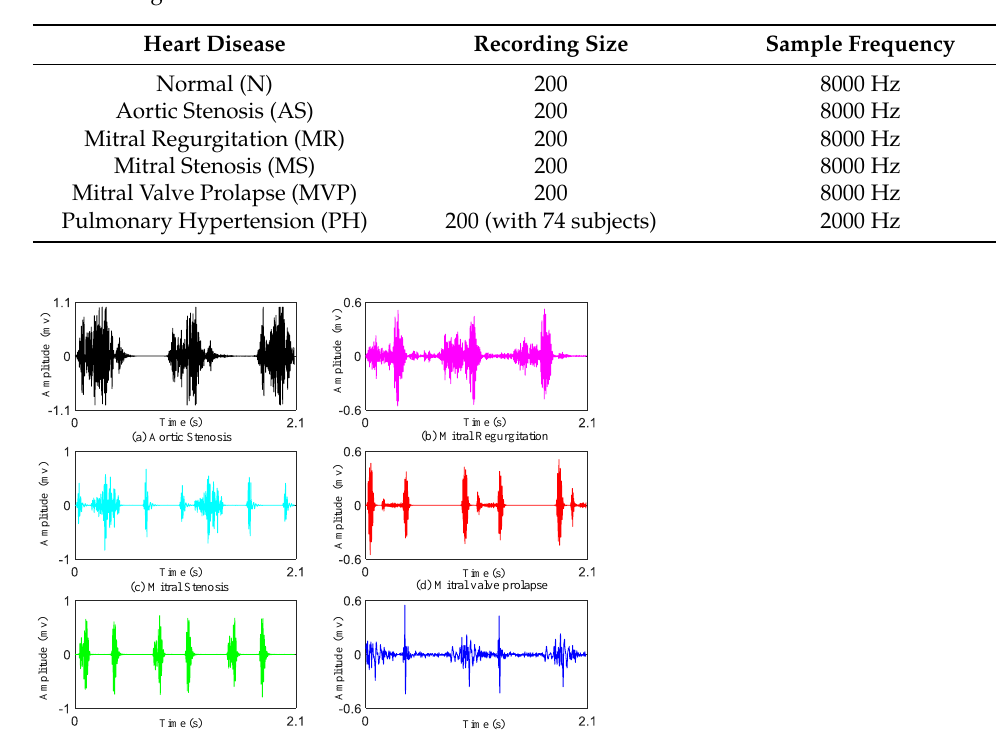
Table 2. Original heart sound database.